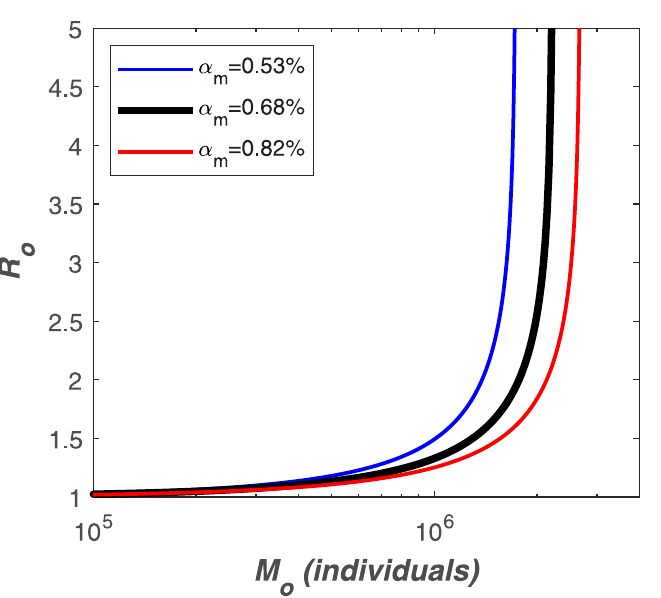
Fig 11. Relation between total mortality ( M